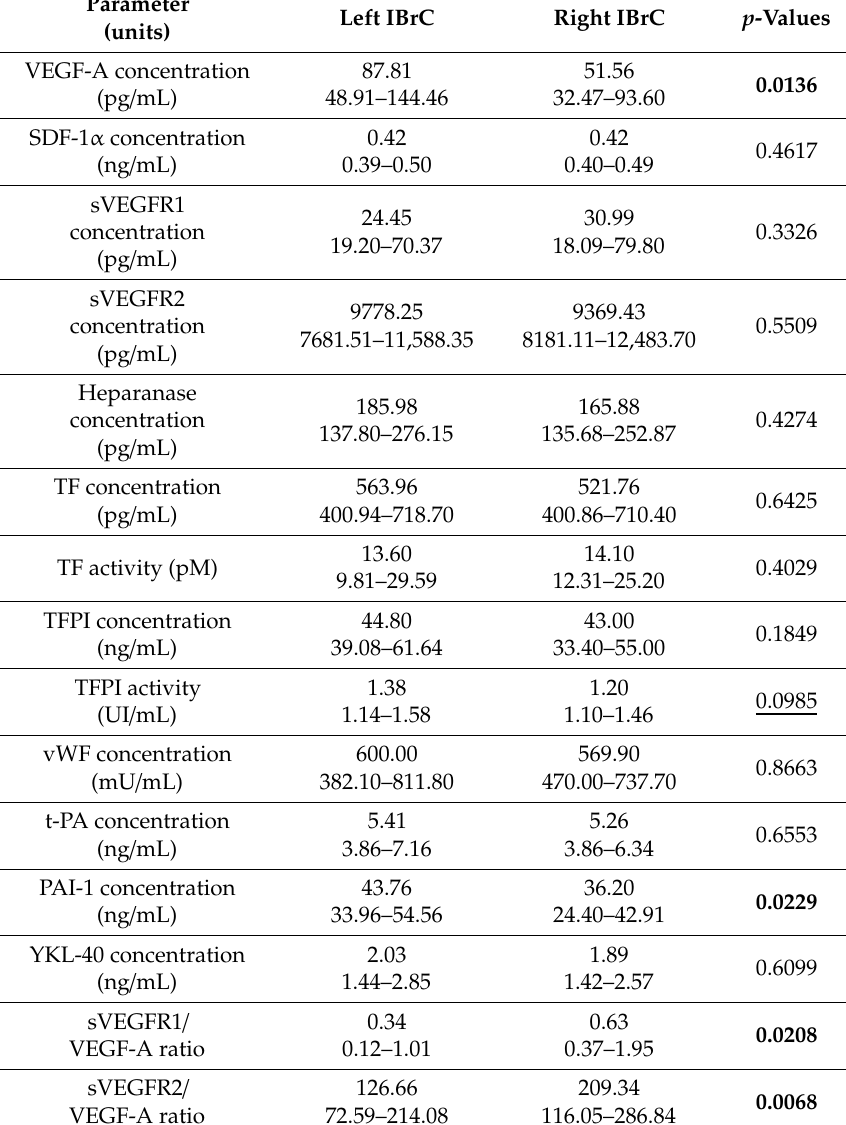
Table 4. Angiogenic, hemostatic, and inflammatory biomarkers according to breast cancer laterality in all breast cancer